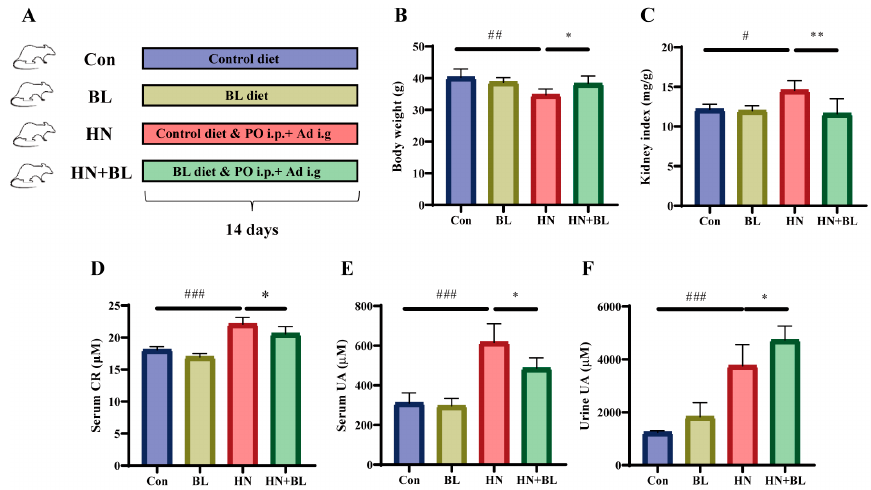
Figure 1. Effect of barley leaf (BL) on the physiological and biochemical indexes in mice with HN. ( A ) Experimental schematic of BL treatment. ( B ) Body weight. ( C ) Kidney index. (Kidney index = kidney weight (mg)/body weight (g)). ( D ) Serum CR. ( E ) Serum UA. ( F ) Urine UA level. Data represent mean ± SD ( n = 6). # p < 0.05, ## p < 0.01, ### p < 0.001 vs. the Con group; * p < 0.05, ** p < 0.01 vs. the HN group.